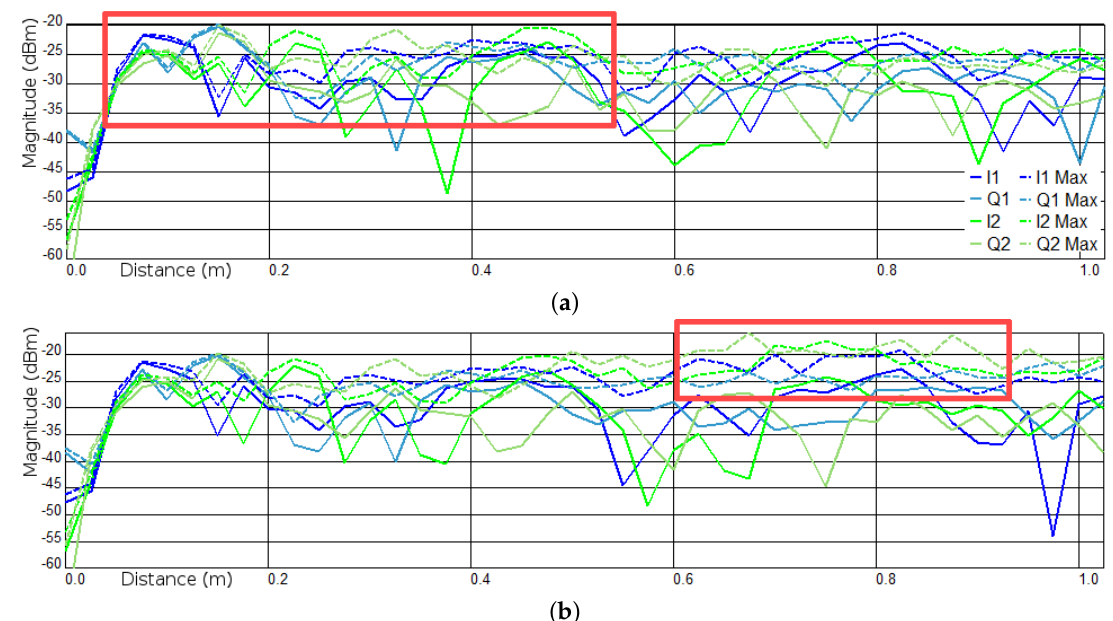
Figure A4. Frequency domain data plots with an insect in H1 ( a ) and H2 ( b ). Vertical axes are the magnitude levels in dBm; horizontal axes are the distances in meters.